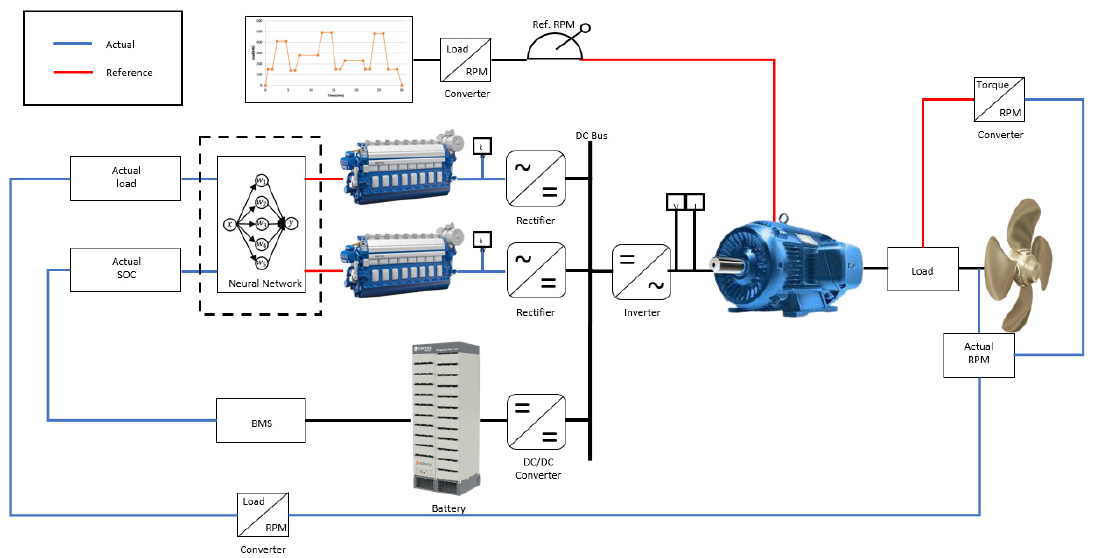
Figure 14. System configuration of generator–battery hybrid system using proposed neural network.